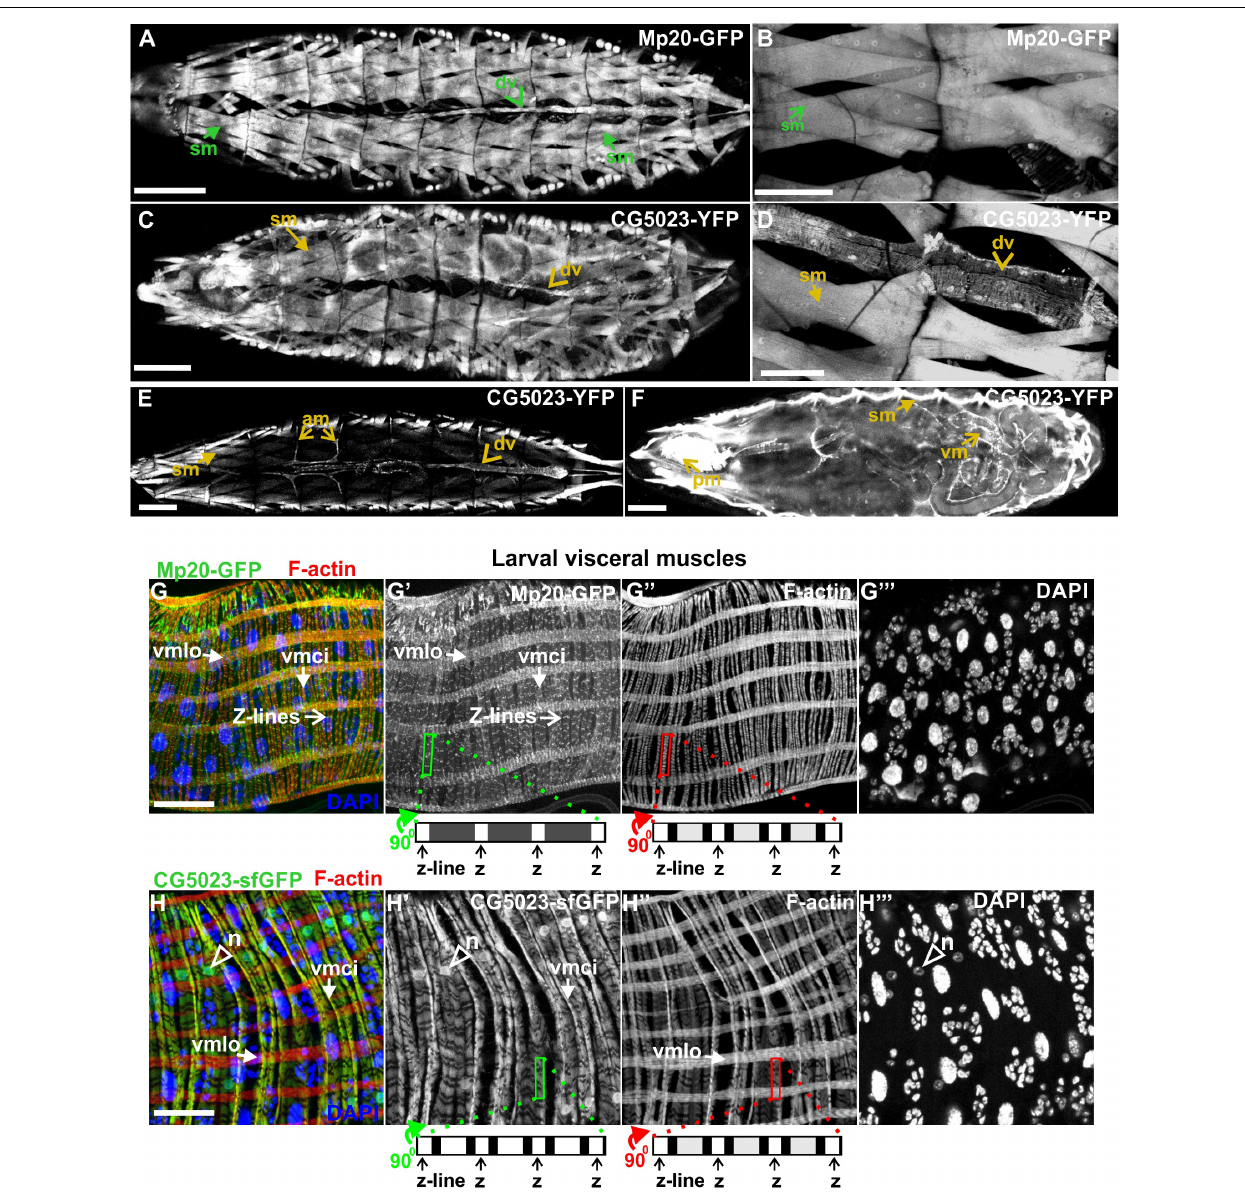
FIGURE 5 | Mp20 and CG5023 protein expression in somatic and visceral muscles in larvae. (A,B) Mp20-GFP is strongly expressed in the full range of somatic musculature along with elevated levels in the dorsal vessel. Likewise (C–E) CG5023-YFP expression pattern demonstrates an endogenous distribution identical to Mp20-GFP in all somatic muscles and dorsal vessel. (F–H) CG5023-YFP, (F) Mp20-sfGFP, (G–G (cid:48)(cid:48) ) and CG5023-sfGFP (H–H (cid:48)(cid:48) ) proteins are preferentially expressed in the circumferential muscles of the gut. (G–G (cid:48)(cid:48) ) Mp20-sfGFP in both circular (vmci) and longitudinal (vmlo) visceral muscles. (F,H–H (cid:48)(cid:48) ) CG5023-YFP and CG5023-sfGFP solely in circular visceral muscles labeling them in a striated pattern along with a rather intense accumulation in their nuclei. Each image is representative of at least three different imaged larvae of the same genotype and markers used. sm, somatic muscle; dv, dorsal vessel; am, alary muscles;